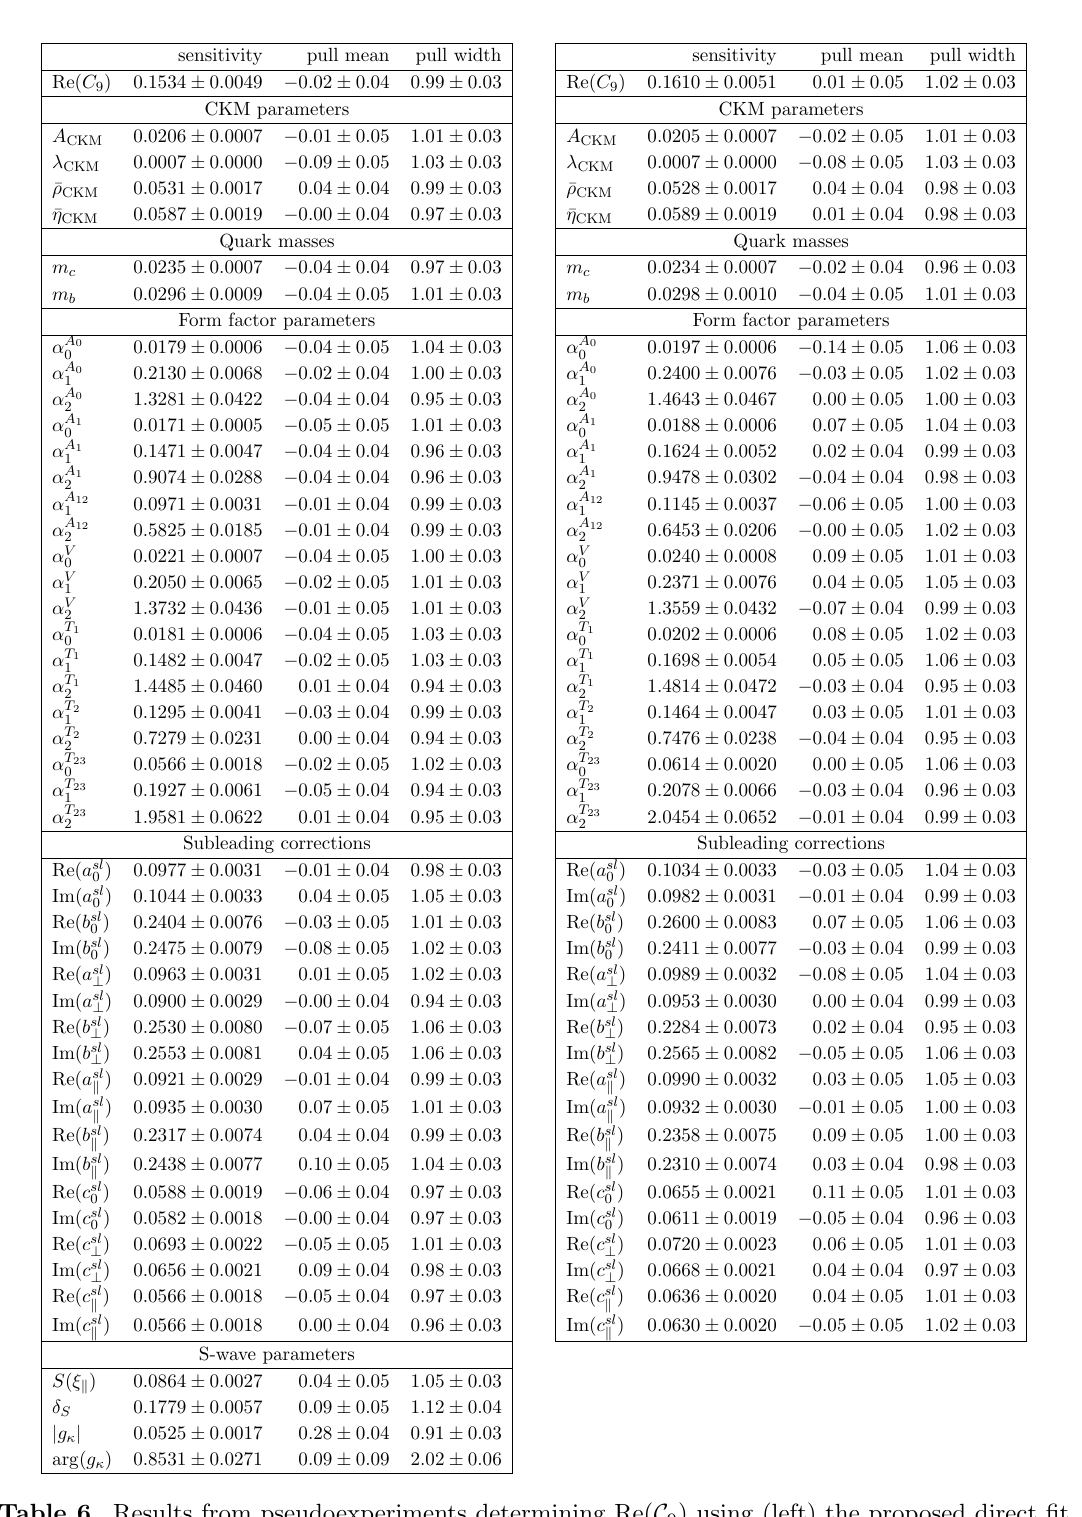
Table 6. Results from pseudoexperiments determining Re( C 9 ) using (left) the proposed direct